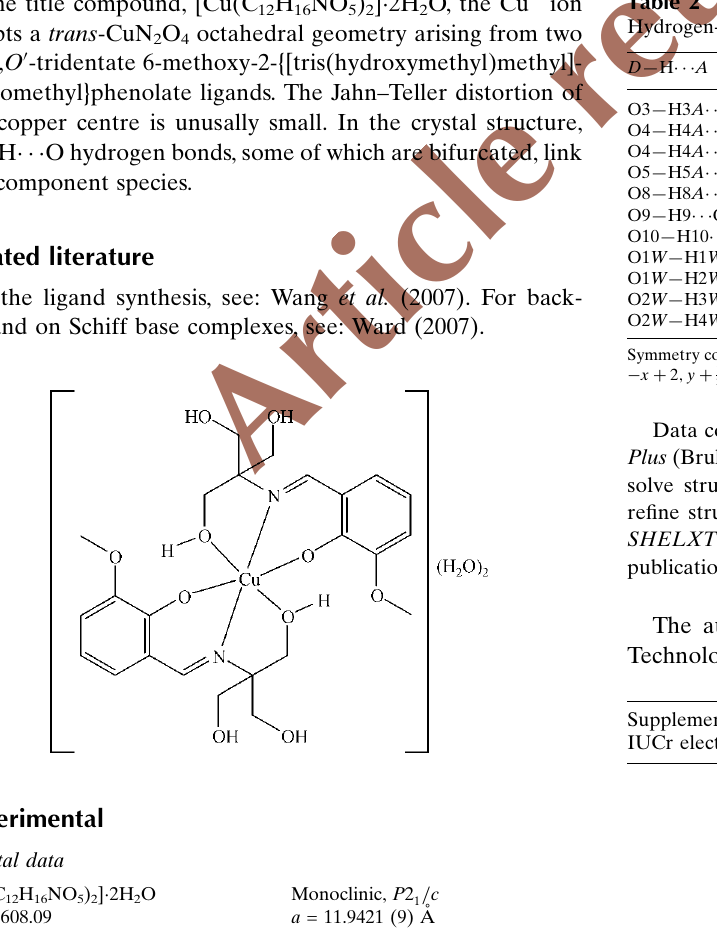
Selected bond lengths (A˚ ).